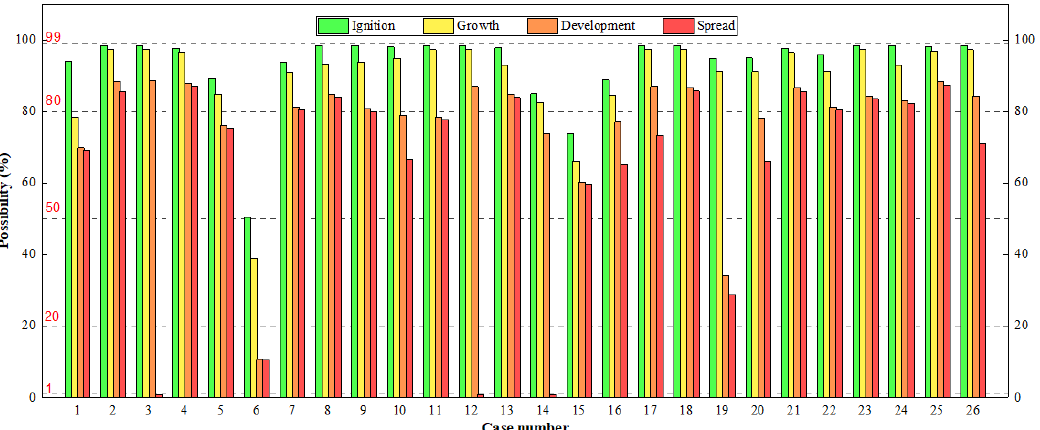
Figure 5. Possibilities from ignition to spread of burning cases in IS. It is gradually reduced.